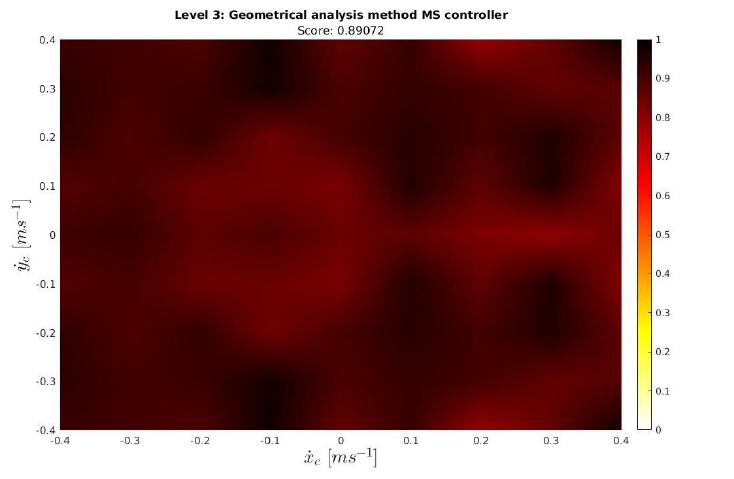
Figure 22. 3D Geometrical analysis for the Managed surge controller.